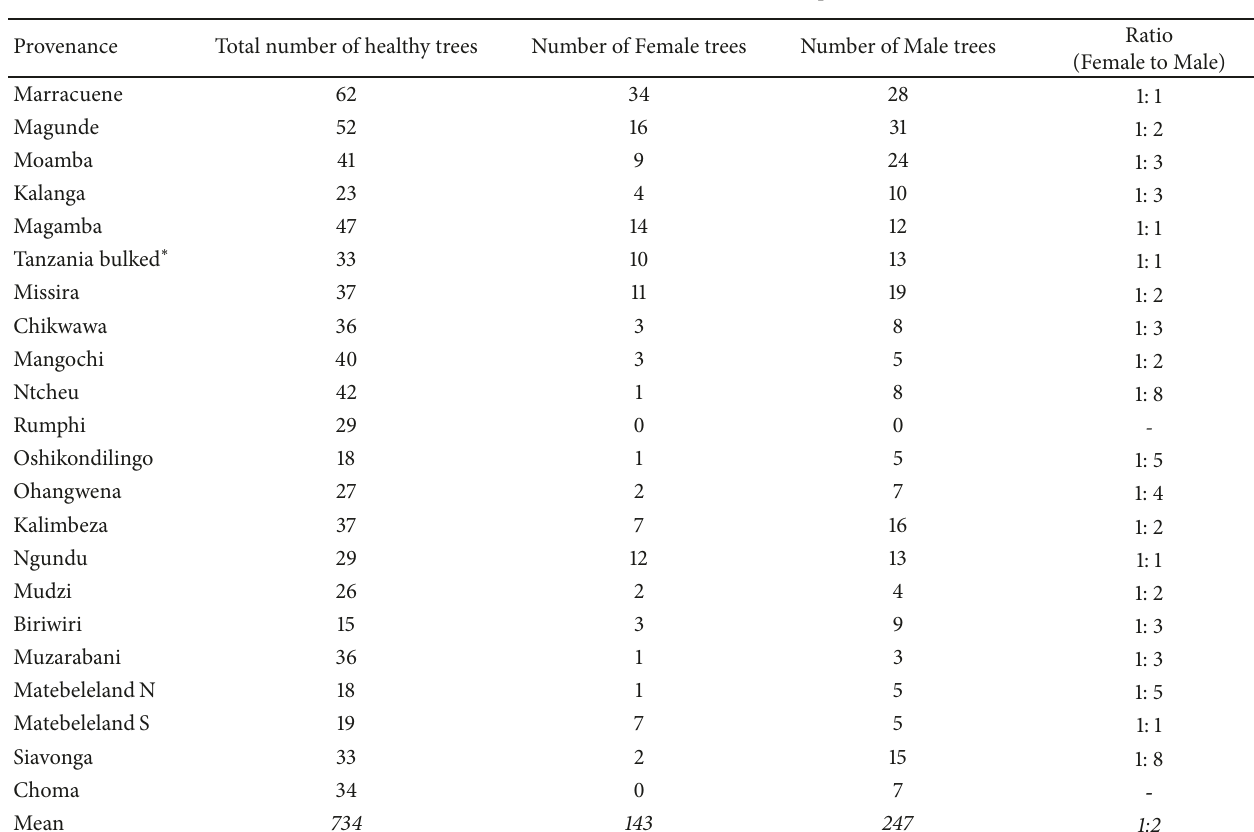
Table 4: Sex ratio of female to male (F: M) in S. birrea